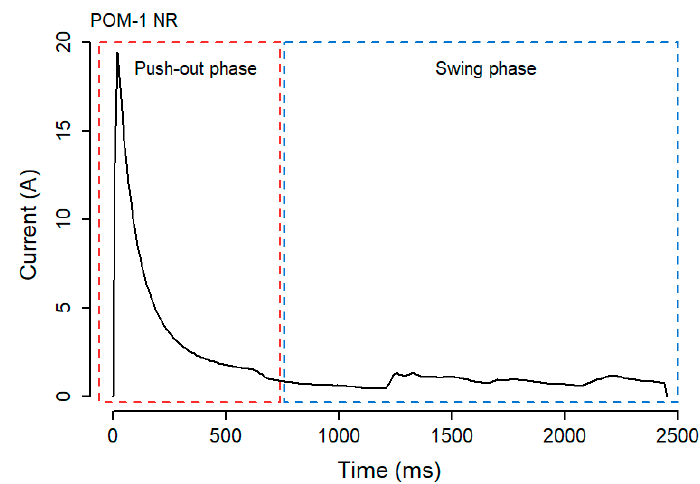
Figure 2. Current draw signal of a single actuation event for point-operating machine POM-1, moving in the NR direction, recorded on the 01st June 2018. The push-out phase (red) and swing phase (blue) of the actuation event are shown.